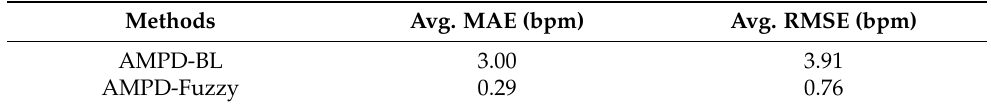
Figure 25. ( a ) A typical run of the estimated heart rate on the static wrist with AMPD-BL; ( b ) A typical run of the estimated heart rate on the static wrist with AMPD-Fuzzy. Table 5. The tracking errors on the static wrist.